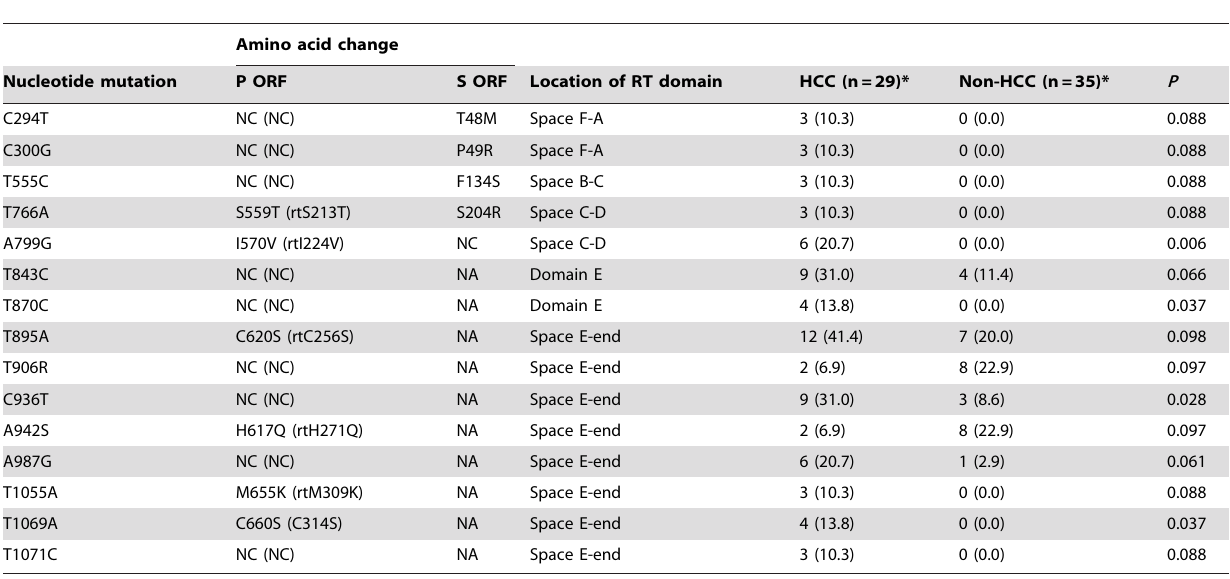
Table 2. Discovery of candidate mutations associated with hepatocellular carcinoma in the reverse transcriptase domain of hepatitis B